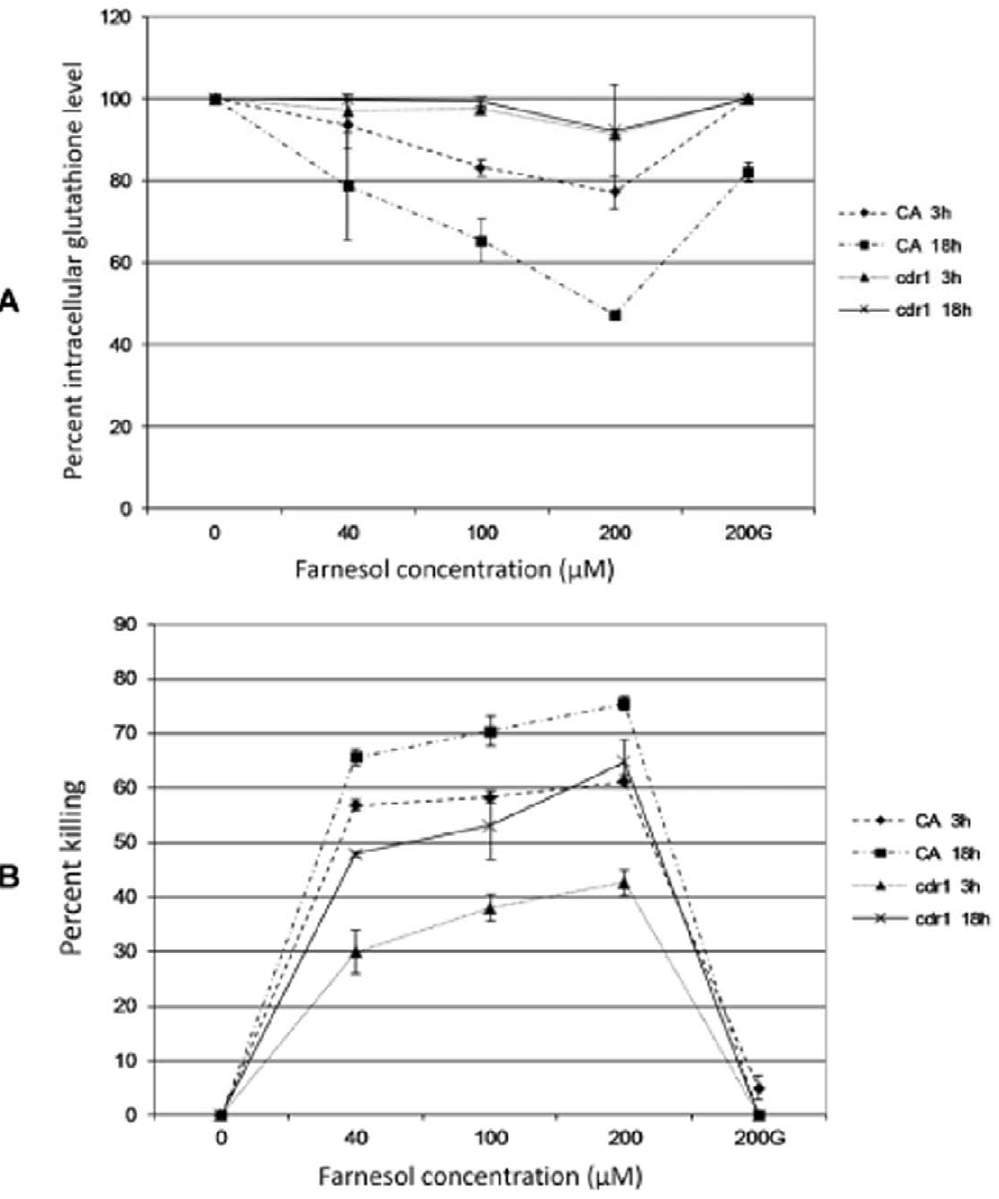
Figure 2. Effect of farnesol on intracellular glutathione levels and viability in CA and cdr1 in the presence and absence of exogenous glutathione following 3 h and 18 h exposure to increasing farnesol concentrations. ( A ) Significant decrease in glutathione levels in CA proportional to farnesol concentration and time of exposure with minimal decrease in glutathione in cdr1 . Exogenous glutathione (G) inhibited drop in intracellular levels in both strains. Error bars indicate the standard errors of the means. ( B ) Farnesol concentration and exposure time-dependent killing of C. albicans with cdr1 exhibiting decreased susceptibility. However, no killing was observed upon supplementation with exogenous glutathione (G). Error bars indicate the standard errors of the